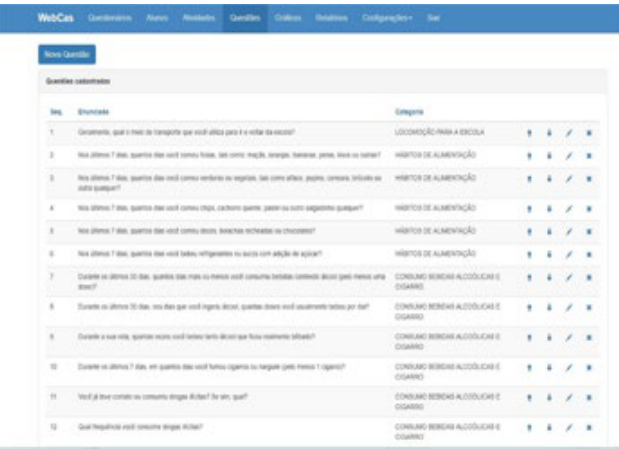
FIGURE 5 - Screen demonstrating the restricted area, activities, and their respective values of energy expenditure in Mets - WebCas.